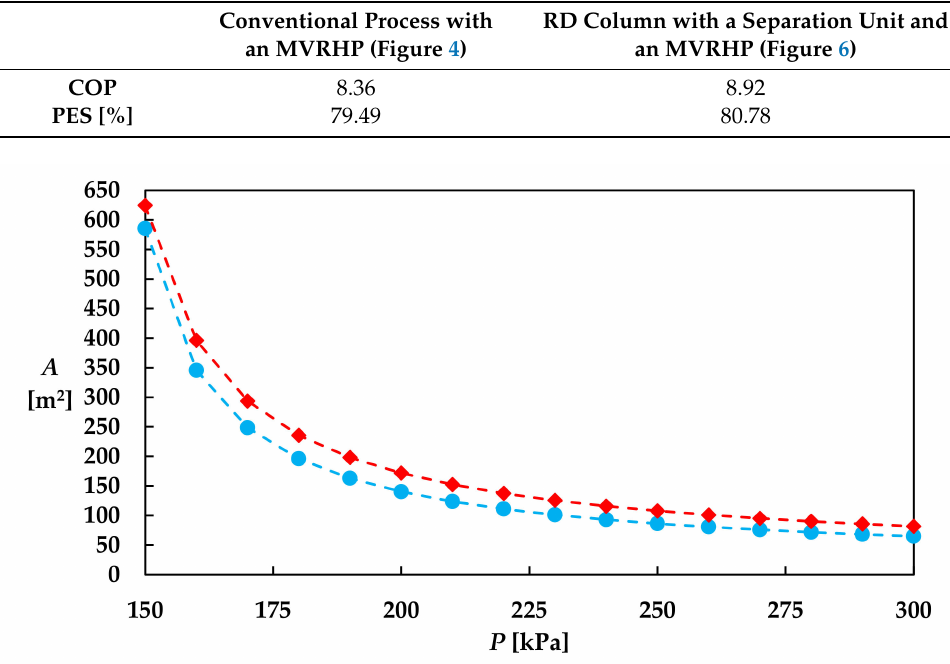
Table 4. Efficiency indicators of designed MVRHP.